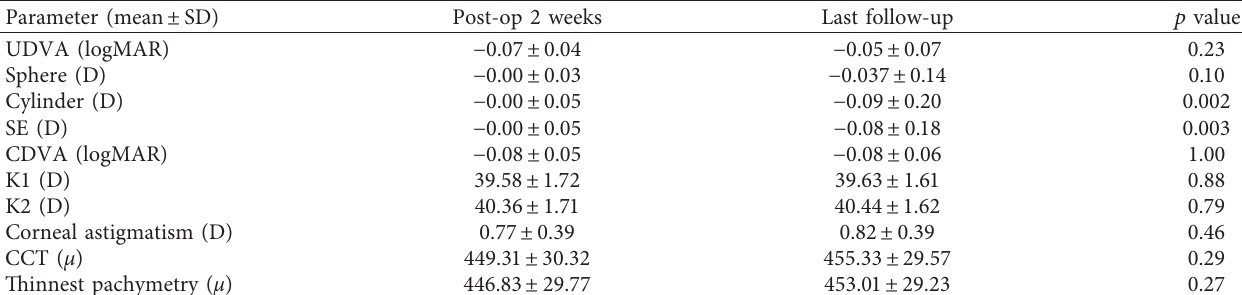
Figure 6: Stability of spherical equivalent refraction. Table 3: Visual and refractive parameters 2 weeks post-op versus mean follow-up in the SMILE